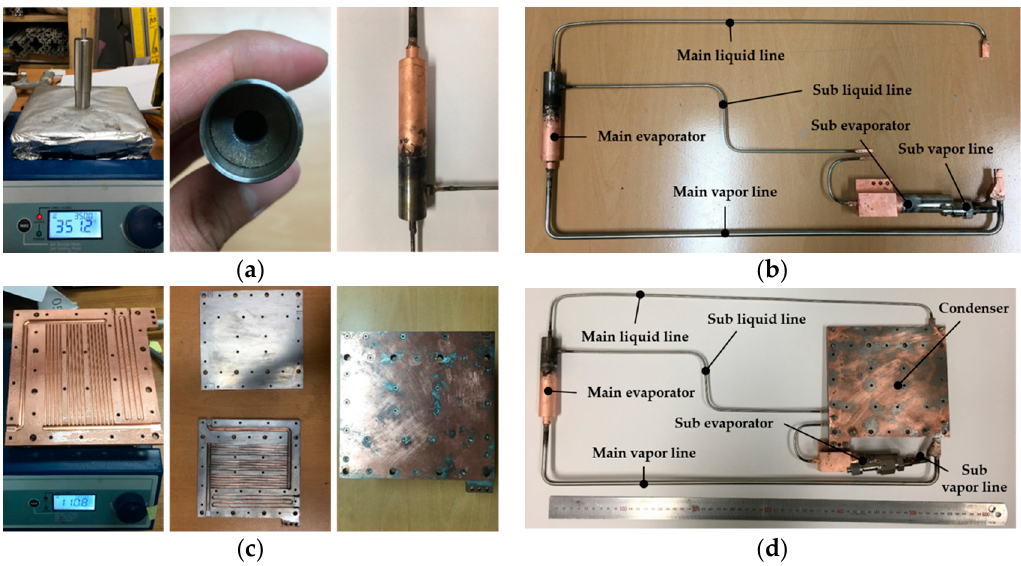
Figure 4. Fabrication process for the CLHP: ( a ) shrinkage fitting of the evaporator; ( b ) assembly of the evaporator and the vapor/liquid line; ( c ) soldering of the condenser assembly ( d ) the complete CLHP.